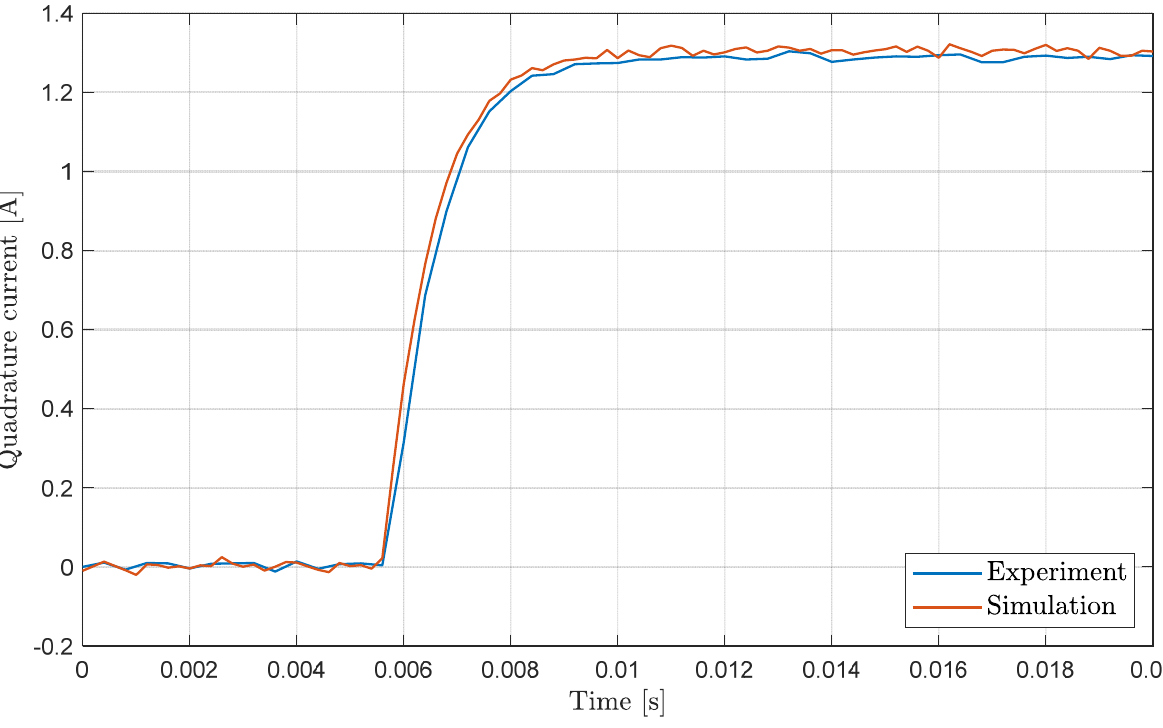
Figure 11. Response to Test 2 (open loop, engaged brakes, 2 V step input applied on quadrature voltage demand).